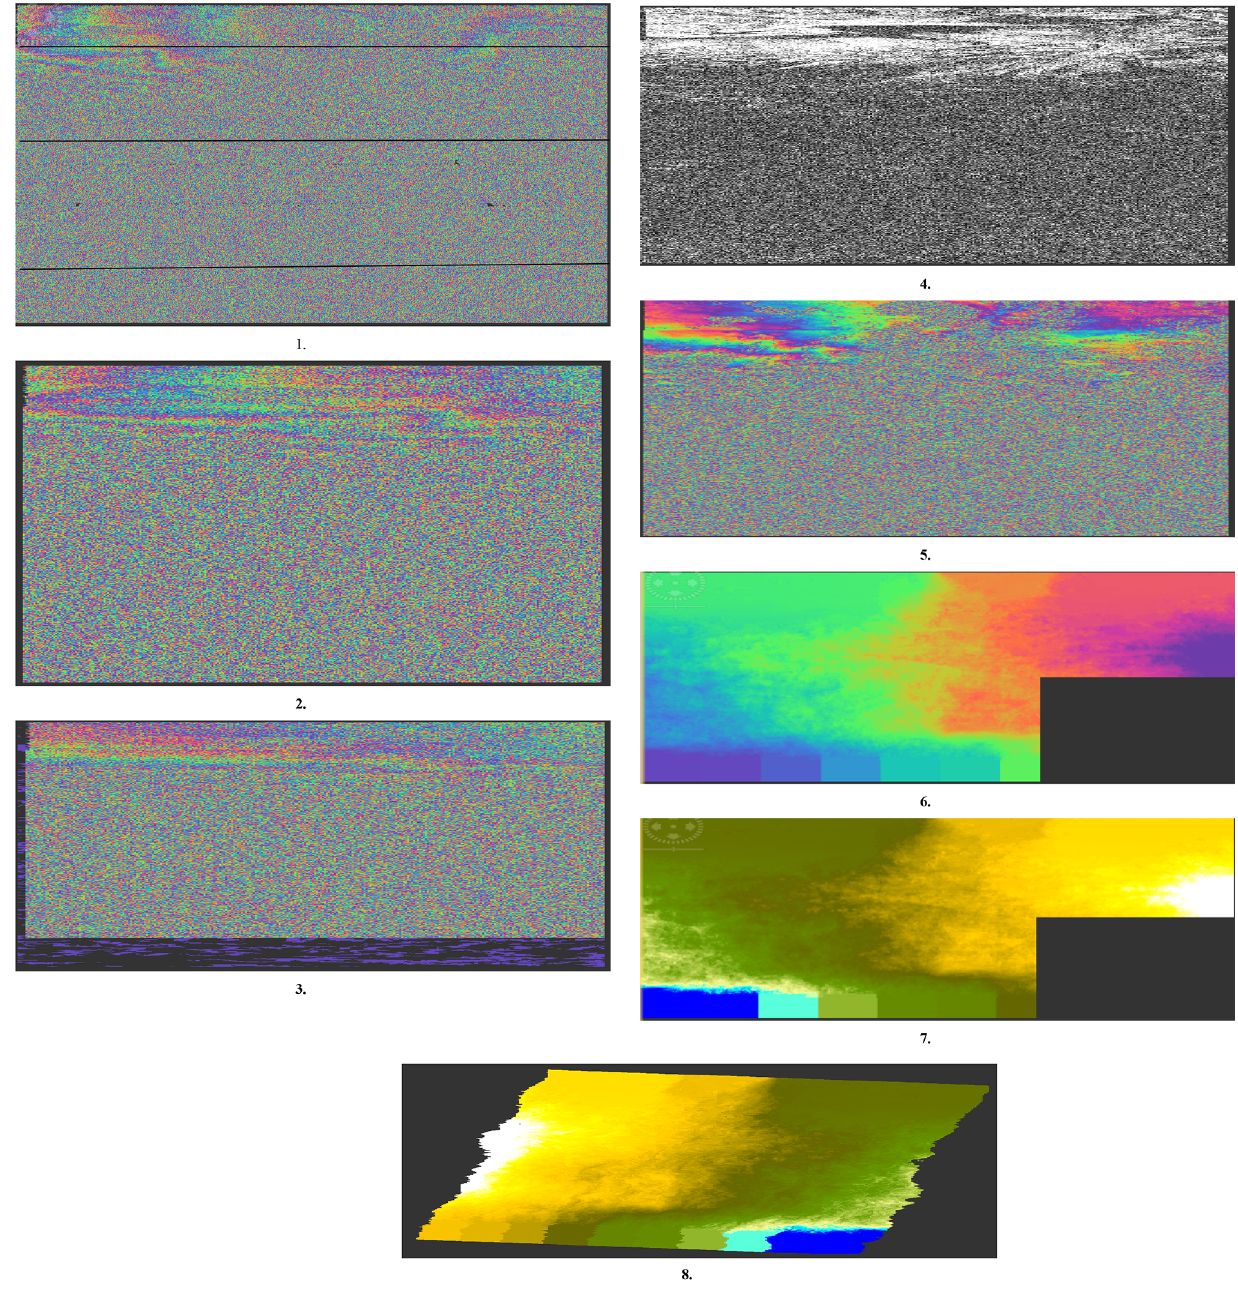
Eastern Nepal (2) Debursting of Eastern Nepal (3)Topographic phase removal of Eastern Nepal (4) Coherence image of Eastern Nepal (5) Multilooking image of Eastern Nepal (6) Unwrapped phase of Eastern Nepal (7) Displacement image of Eastern Nepal (8) Terrain corrected image of displacement of Eastern